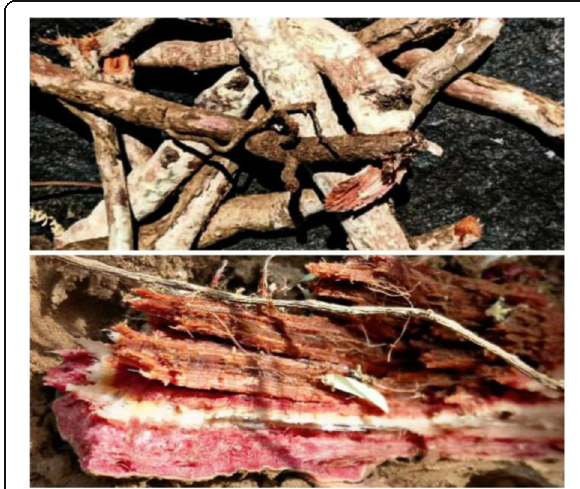
Fig. 2 Morphology of Sterculia urens Roxb.